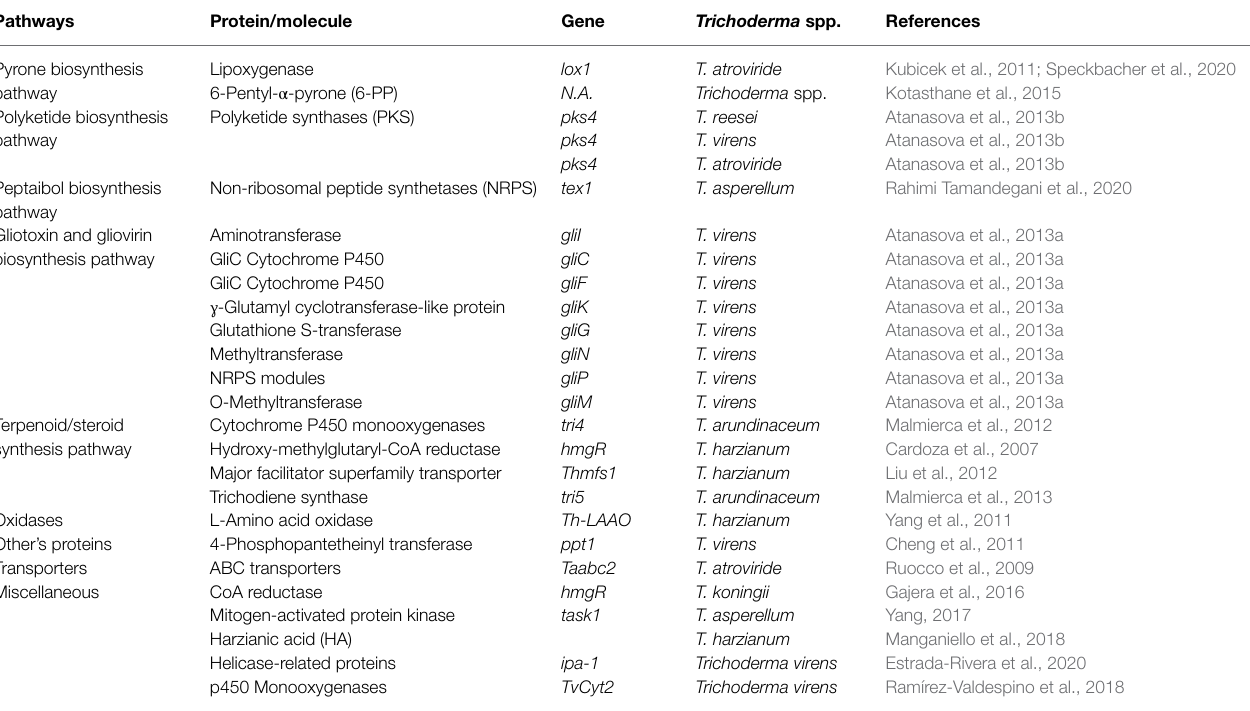
TABLE 3 | Role of Trichoderma spp. genes involved in the antagonism and synthesis of secondary metabolites deleterious to R.